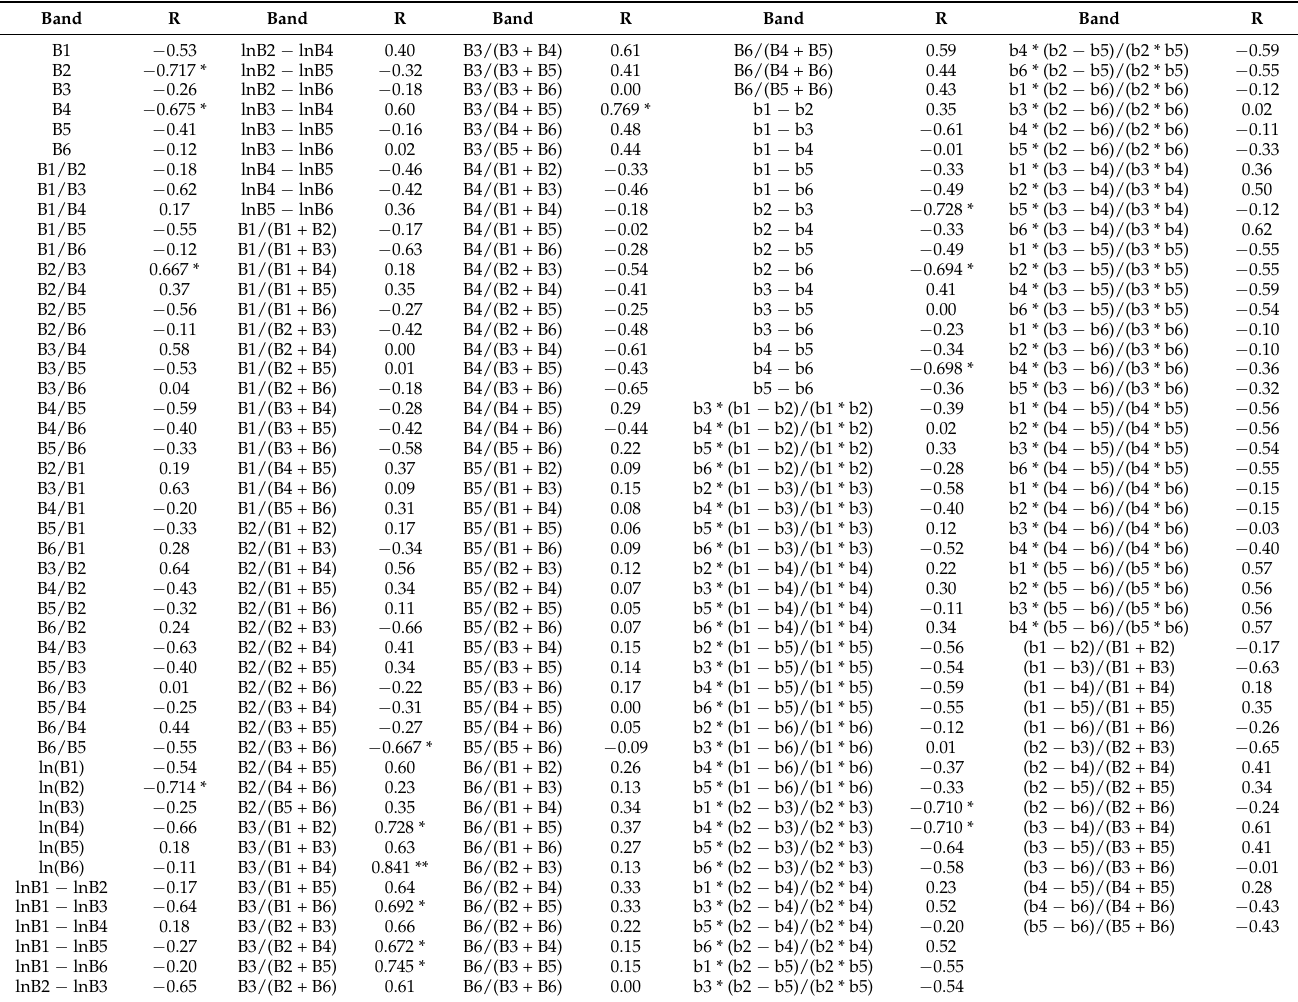
Table A1. Sensitivity testing (N = 237) between bands and